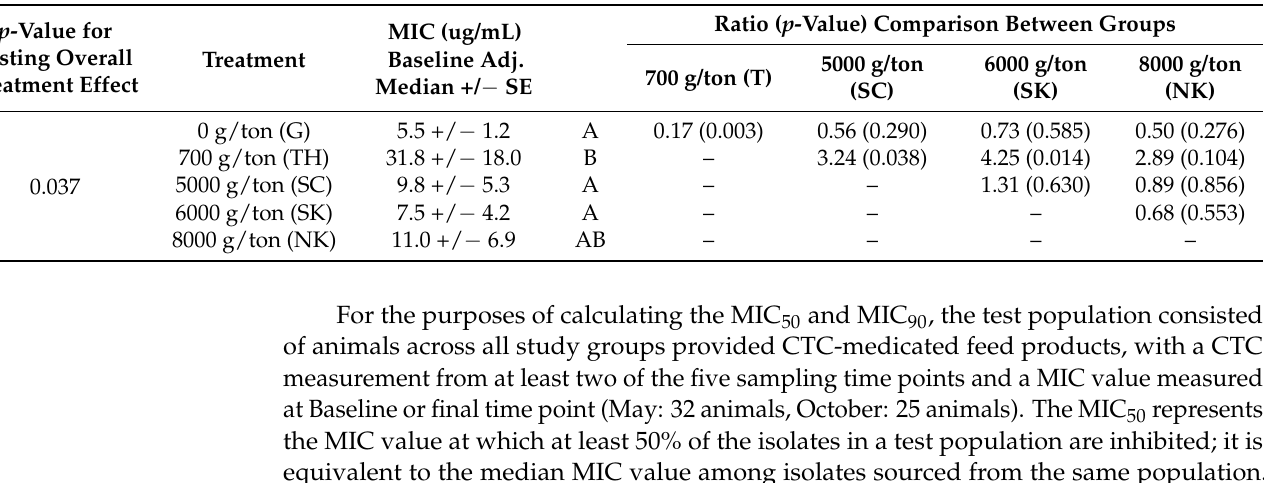
Table 2. Across-time comparison of median MIC values in treatment groups of pastured cattle provided four different FDA- approved formulations of CTC-medicated mineral products. Treatment groups with the same letter were not significantly different in their pairwise